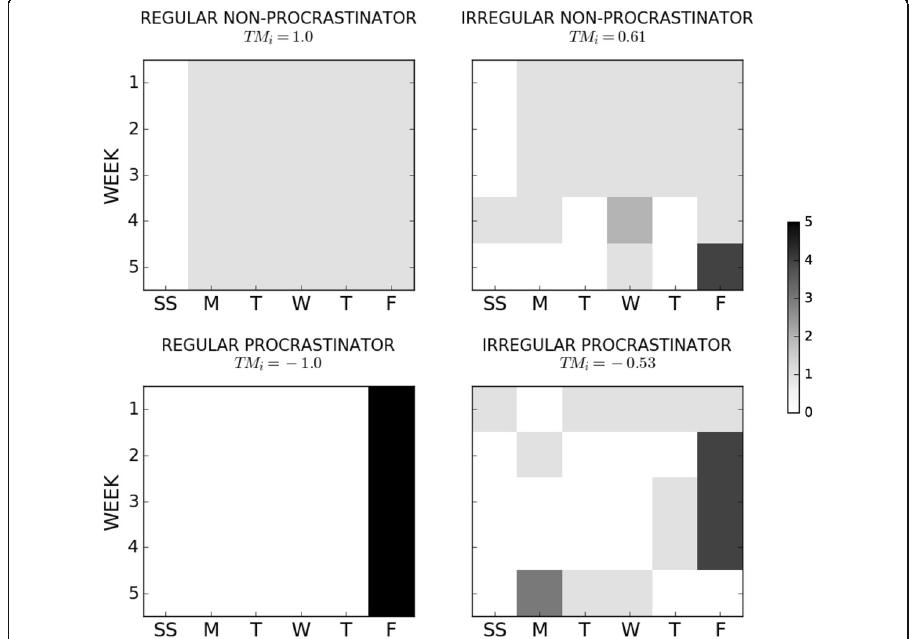
Fig. 6 Number of daily activity counts for four prototypical students. Figure based on data and analyses in Park et al. (2018)